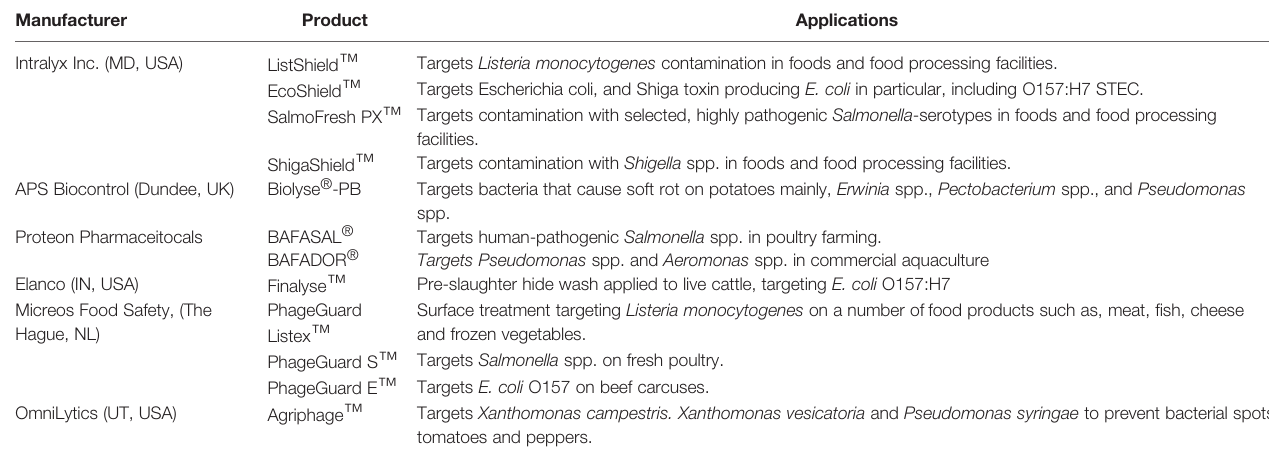
TABLE 4 | Phage products approved for use in food manufacturing. These phage products have the opportunity to enter the GI tract and impact the gut